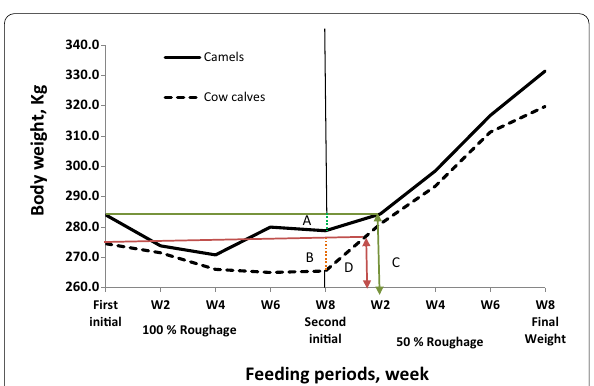
Fig. 1 Body weight change of camels and cow calves fed 100% and 50% roughage. A body weight loss of camels, B body weight loss of calves, C recovery weight period of camels and D recovery weight period of cow calves (recovery period period needed to reach the = 1st initial